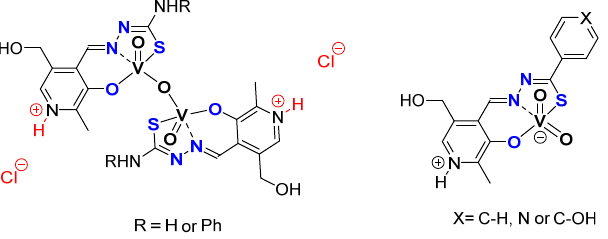
Table 10. Results of CO epoxidation under organic solvent-free conditions with vanadium com- plexes from Figure 20.